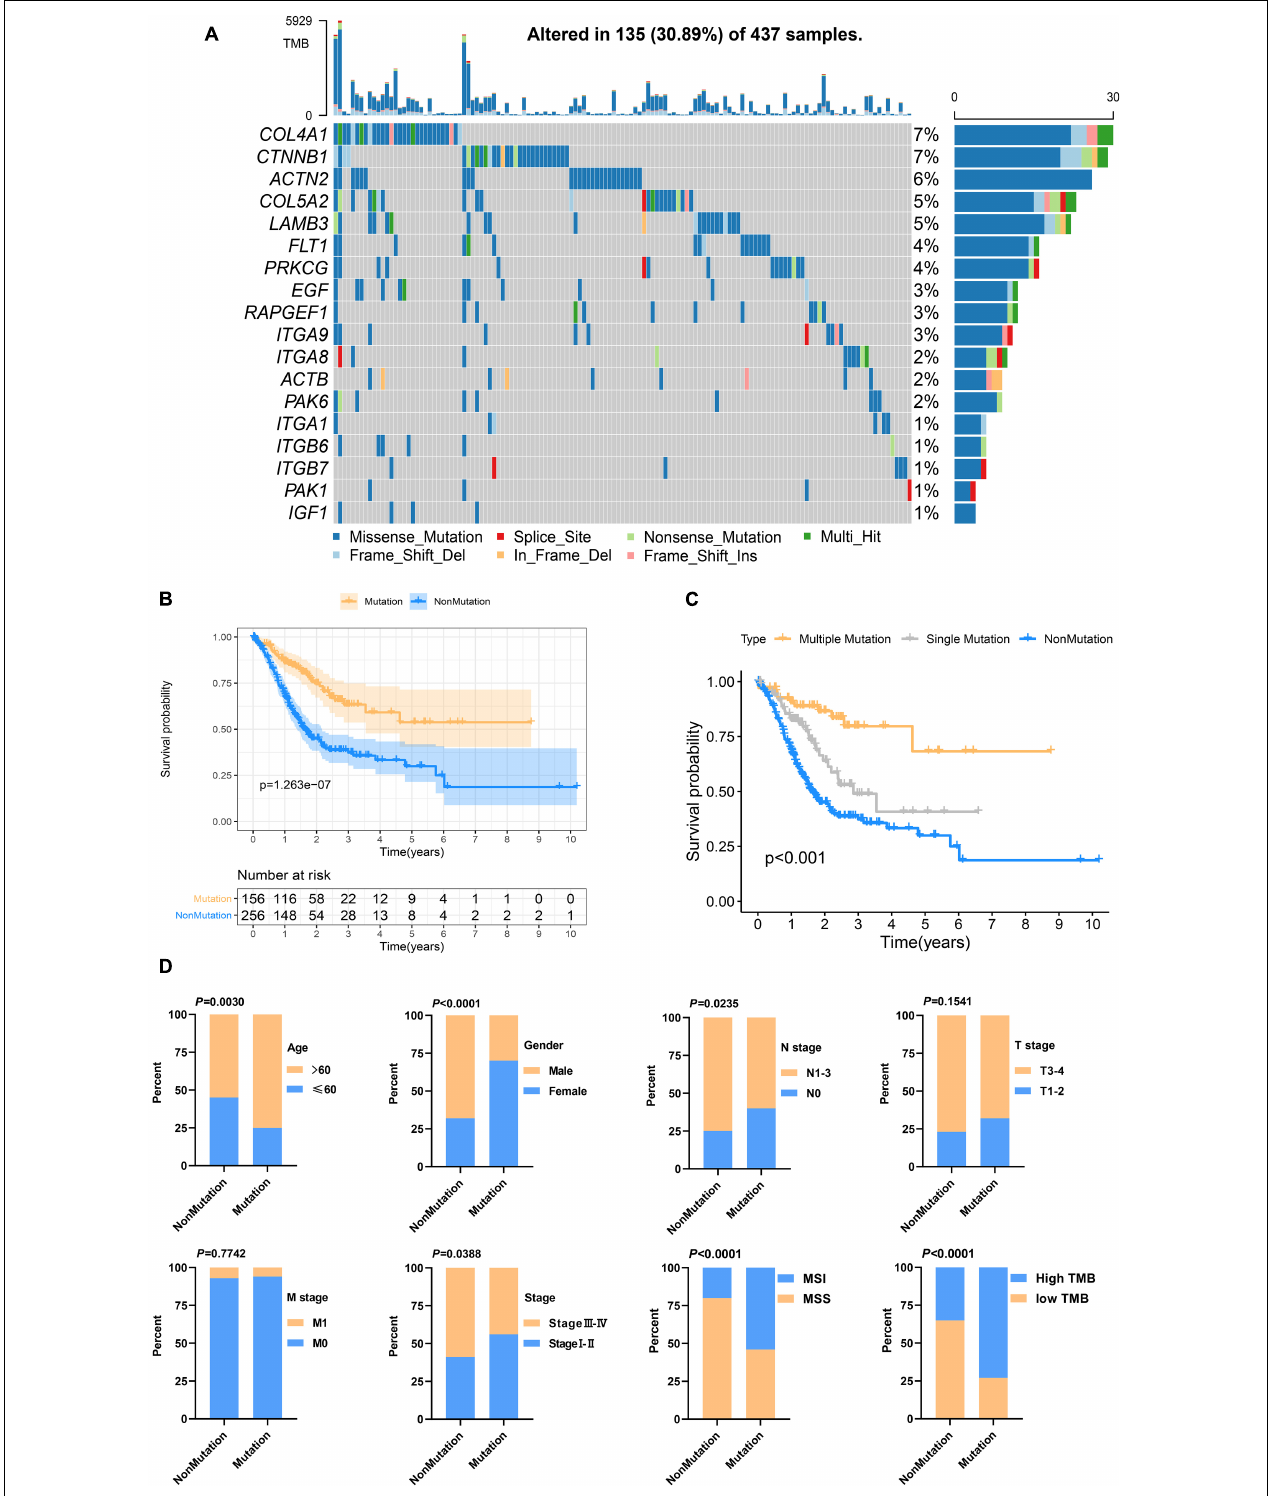
FIGURE 3 | Focal adhesion mutations are closely related to the prognosis and clinicopathological characteristics of GC patients (A) The mutation frequency of 18 focal adhesion-related genes in 437 GC patients in the TCGA cohort. (B) Kaplan-Meier curve shows that the survival time of the focal adhesion mutation group of GC patients in the TCGA cohort is significantly longer than that of the non-mutation group. (C) The overall survival of GC patients under different mutation types. (D) Chi-square test shows that the focal adhesion mutation is closely related to the clinicopathological characteristics.